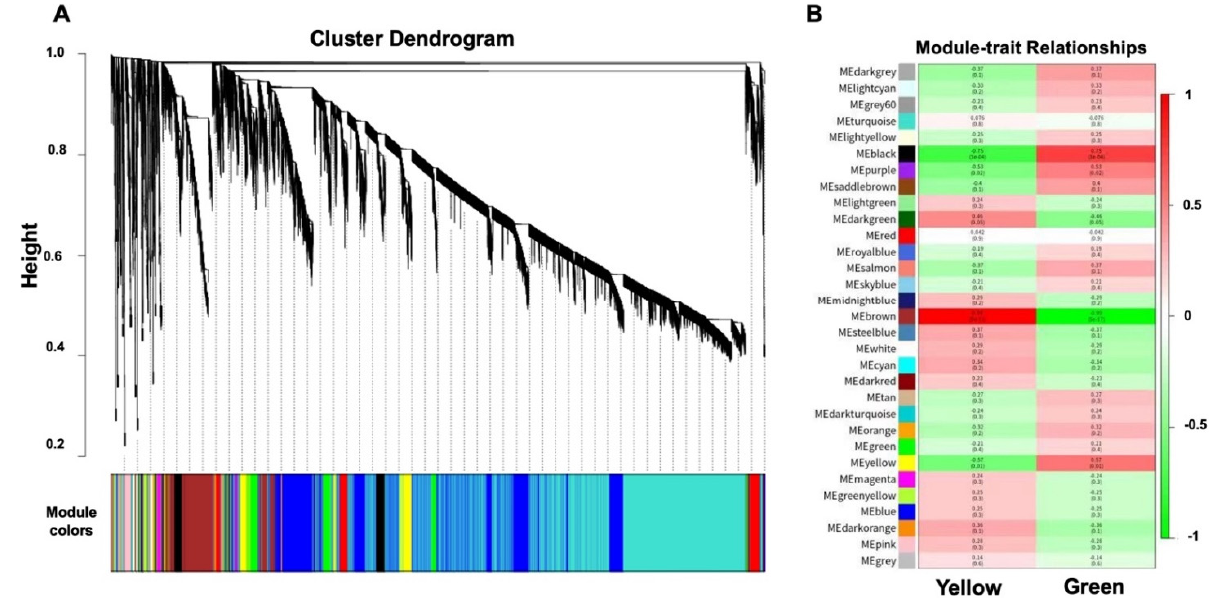
Figure 6. The weighted gene co-expression network analysis (WGCNA) of identified DEGs during the three developmental stages of MR-1 and M4-7. ( A ) Hierarchical cluster tree showing 31 modules of co-expressed genes, where each DEs is represented by a leaf in the tree, and each of the 31 mod- ules is represented by a major tree branch. The lower panel shows modules in designated colors, such as yellow and black. ( B ) The module of the green stigma exhibits correlations and p -values (in